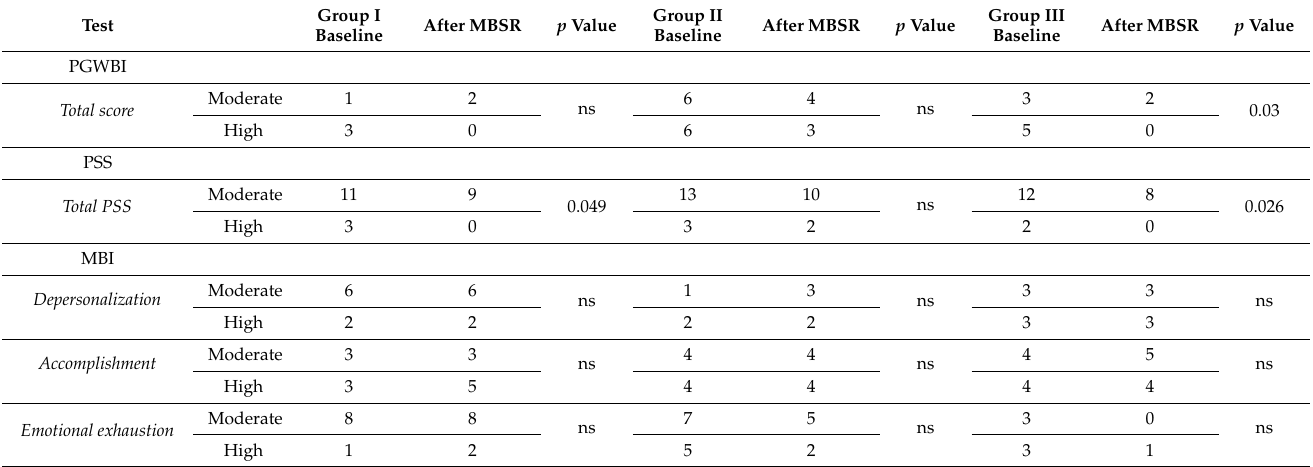
Figure 2. Percentage of change of PGWBI total score, total PSS, and the three MBI domains (deperson- alization, accomplishment, and emotional exhaustion) between the two questionnaire administrations in the three WL and MSRB groups. Abbreviations: MBI: Maslach Burnout Inventory; PGWBI: Psy- chological General Well-Being Index; PSS: Perceived Stress Scale.